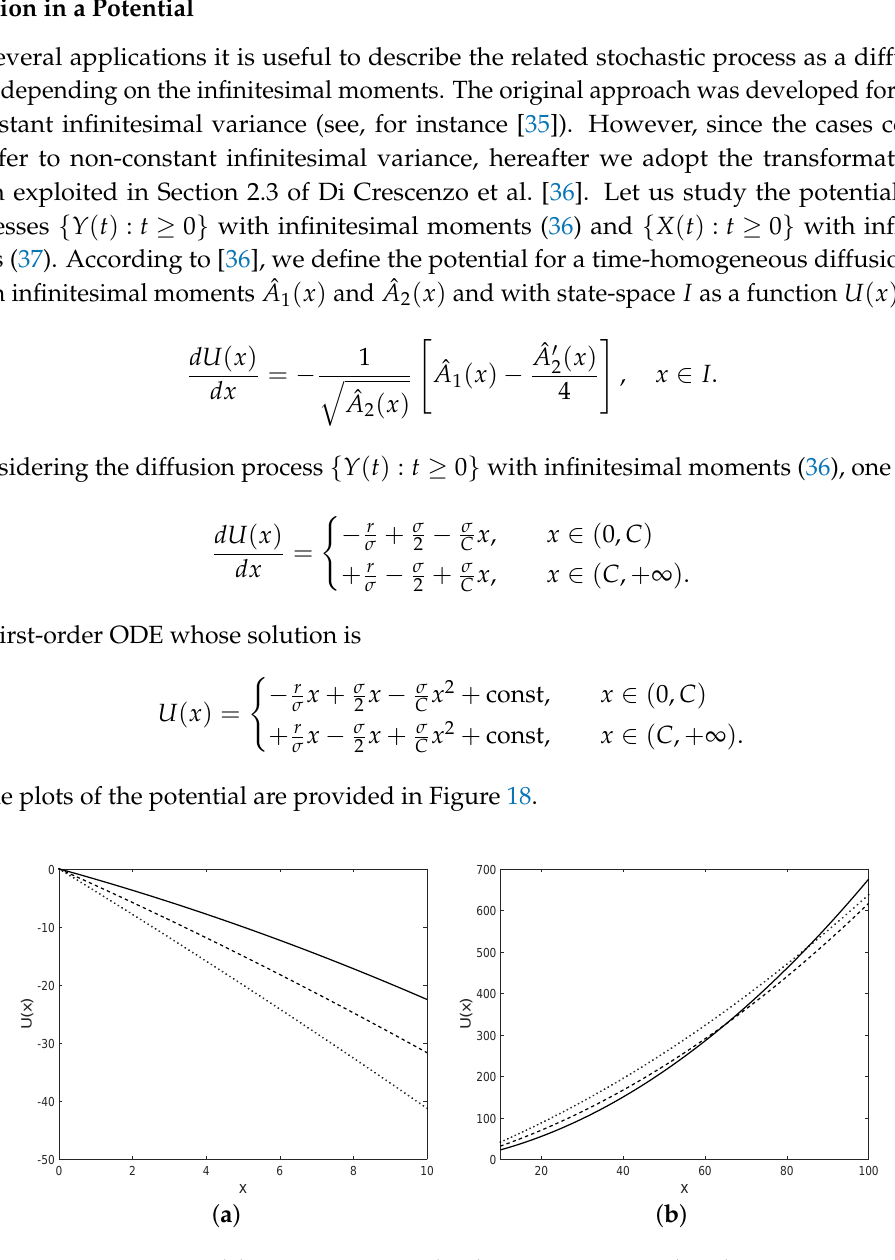
Figure 18. The potential U ( x ) is plotted for x ∈ ( 0, C ) in ( a ) and for x ∈ ( C , ∞ ) in ( b ) and for C = 10, r = 1, y = 1, σ = 1/2 (solid line), σ = 1/3 (dashed line), σ = 1/4 (dotted line), with the initial condition U ( 0 ) =